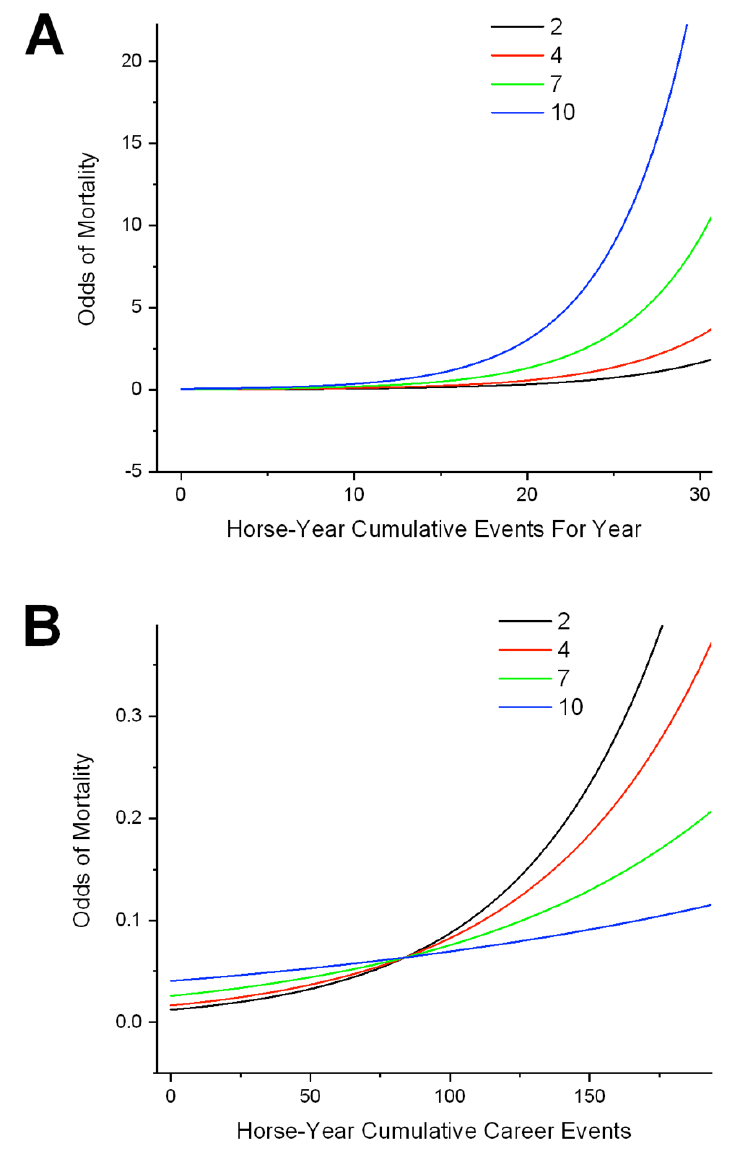
Figure 6. Odds of mortality (statistical mean, unit of interest-horse-year), showing relationships between AGE and indices of cumulative work for standardbred horses racing in the Province of Ontario from 2003–2015, and describing significant interactions identified through logistic regression analysis of mortality data from the Ontario Death Registry. Population—all horse-years for horses racing in the Province in the study period ( n = 125,200). Maximum cumulative year work-events (CMYR) in this dataset was 57, maximum cumulative career work-events (CMCAR) was 486. Curves are theoretical and describe the trajectory of the relationships identified; many horses, particularly younger animals, would not achieve the number of work-events described. ( A ) AGE × CMYR (cumulative work-events for the year). As AGE rises, the impact of rising CMYR on mortality odds accelerates, suggesting decreasing tolerance of annual workload with increasing age. ( B ) For the interaction AGE × CMCAR at horse-year level, increasing cumulative career work-events has the reverse effect, odds increasing more rapidly for younger than older horses. Trajectories speak to the impact of career intensity. Both sets of relationships are influenced by progressive withdrawal of less robust horses and a survivor effect. Note the differences in scale for the Y axes. Impacts on mortality odds are smaller in B than A, suggesting workloads compressed into shorter periods may be more damaging than equivalent loads that are more spread out.